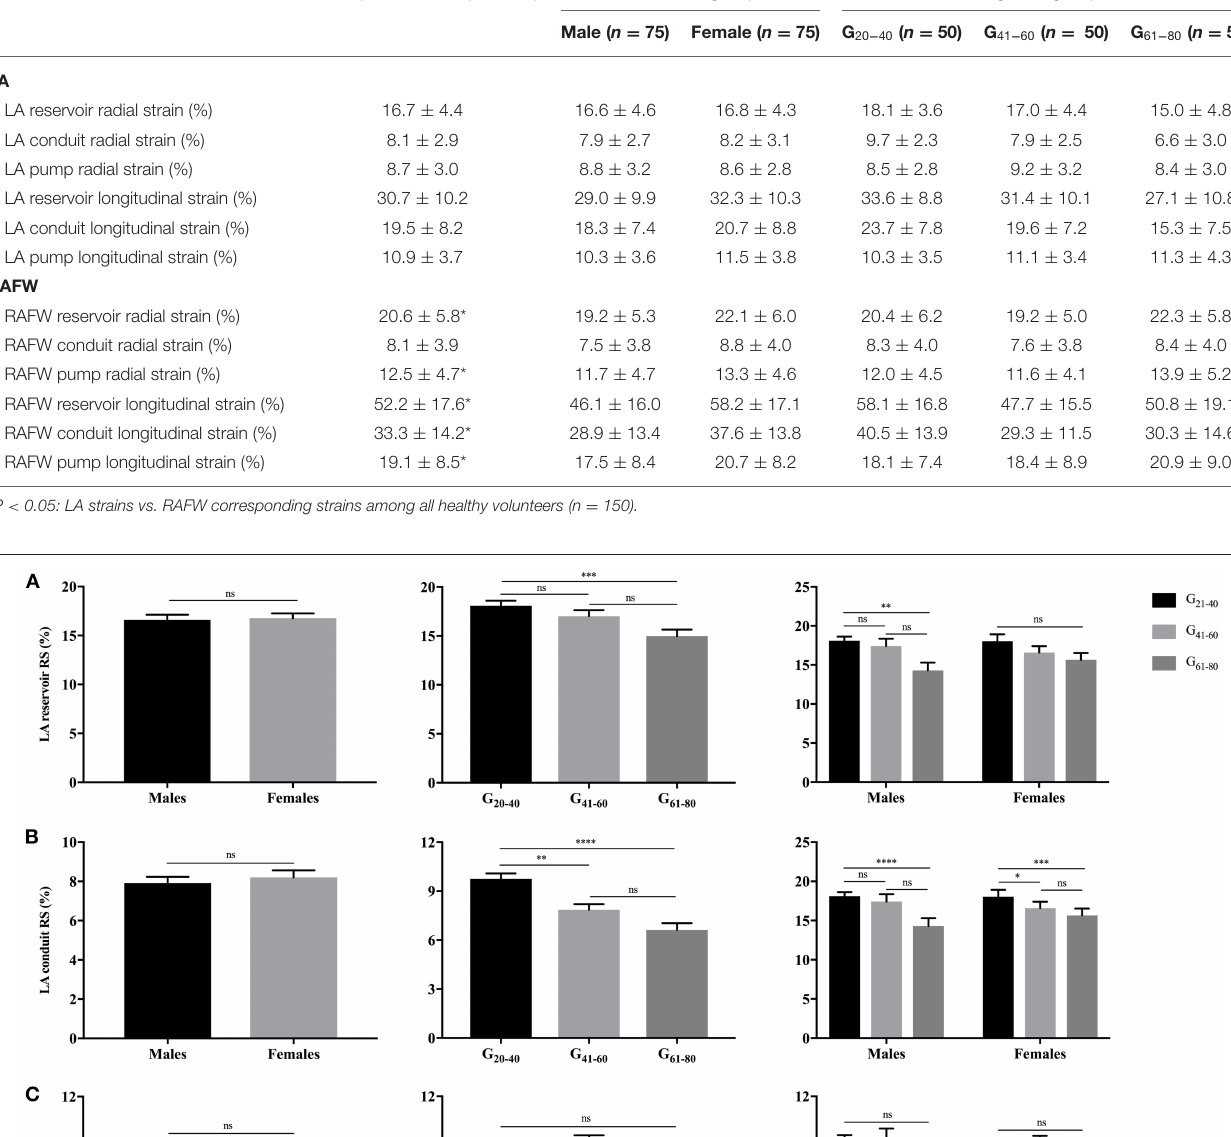
TABLE 2 | Bi-atrial reservoir, conduit and pump radial, and longitudinal strains. Healthy volunteers ( n = 150)